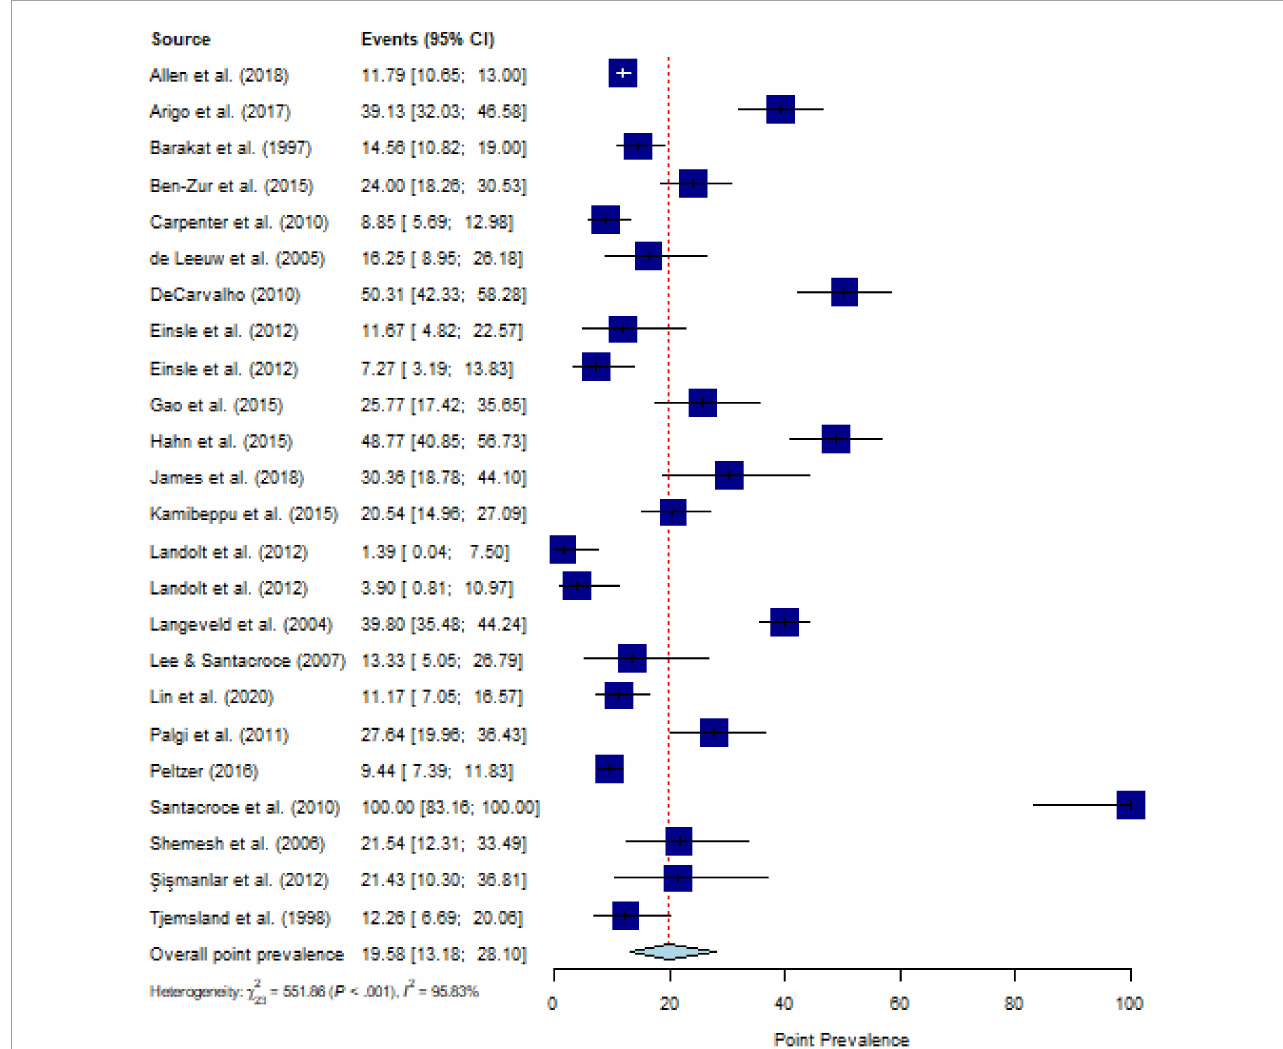
FIGURE3 Forest plot of point prevalence of post-traumatic stress symptoms (PTSS) in people with chronic somatic diseases (CD).